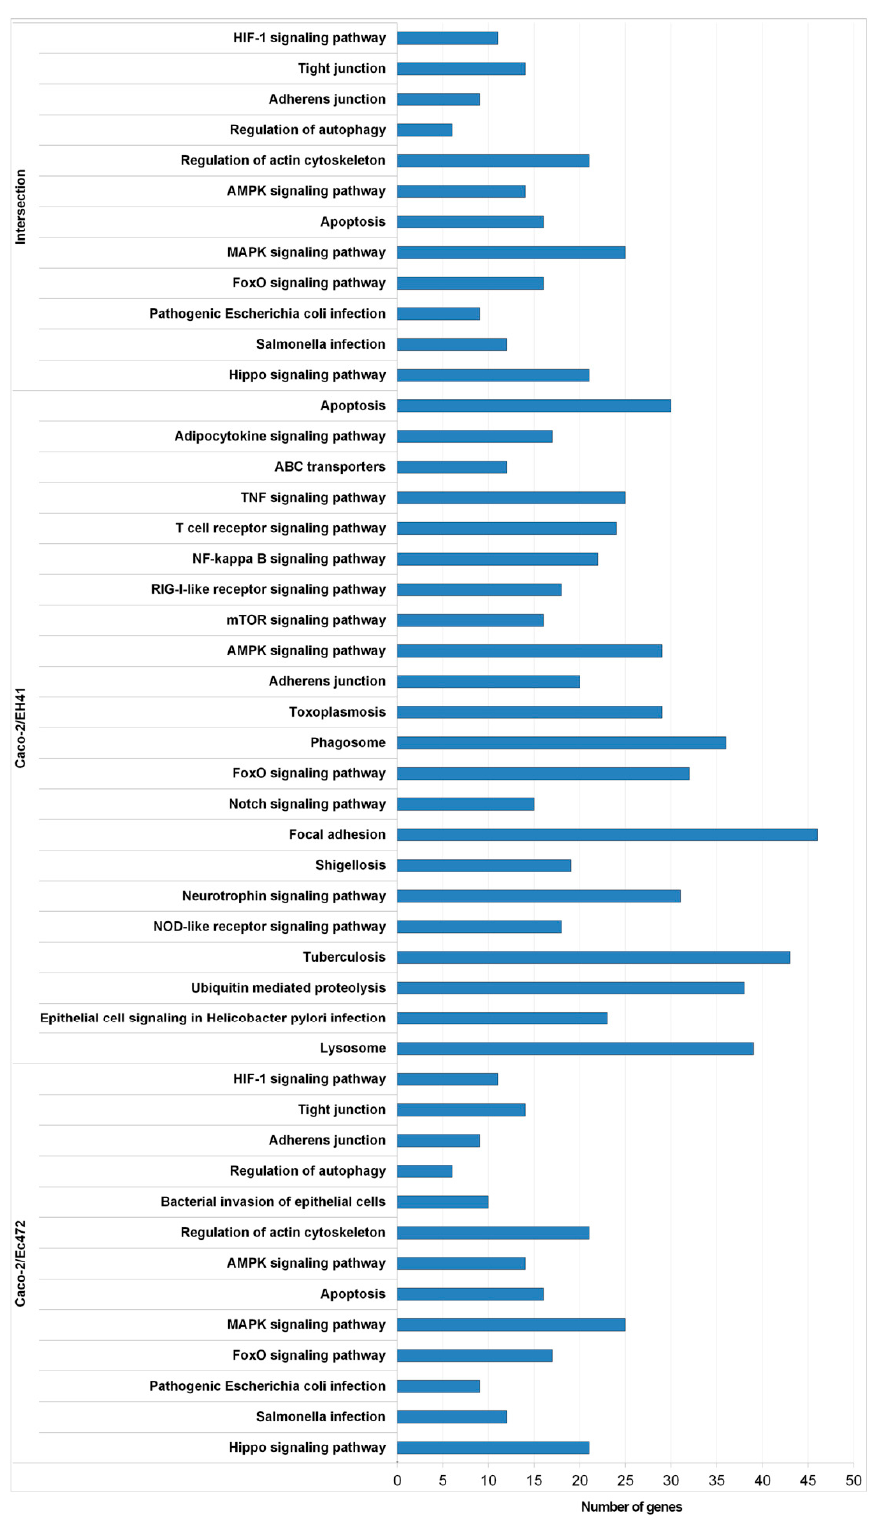
Figure 3. DE genes enrichment analysis based on KEGG pathways. Distribution of the KEGG pathways found in three sets of DE genes. Intersection stands for common DE genes in Caco-2/EH41 and in Caco-2/Ec472 groups. Caco-2/EH41 stands for DE genes present only in Caco-2/EH41 group. Caco-2/Ec472 stands for DE genes present only in Caco-2/Ec472 group.